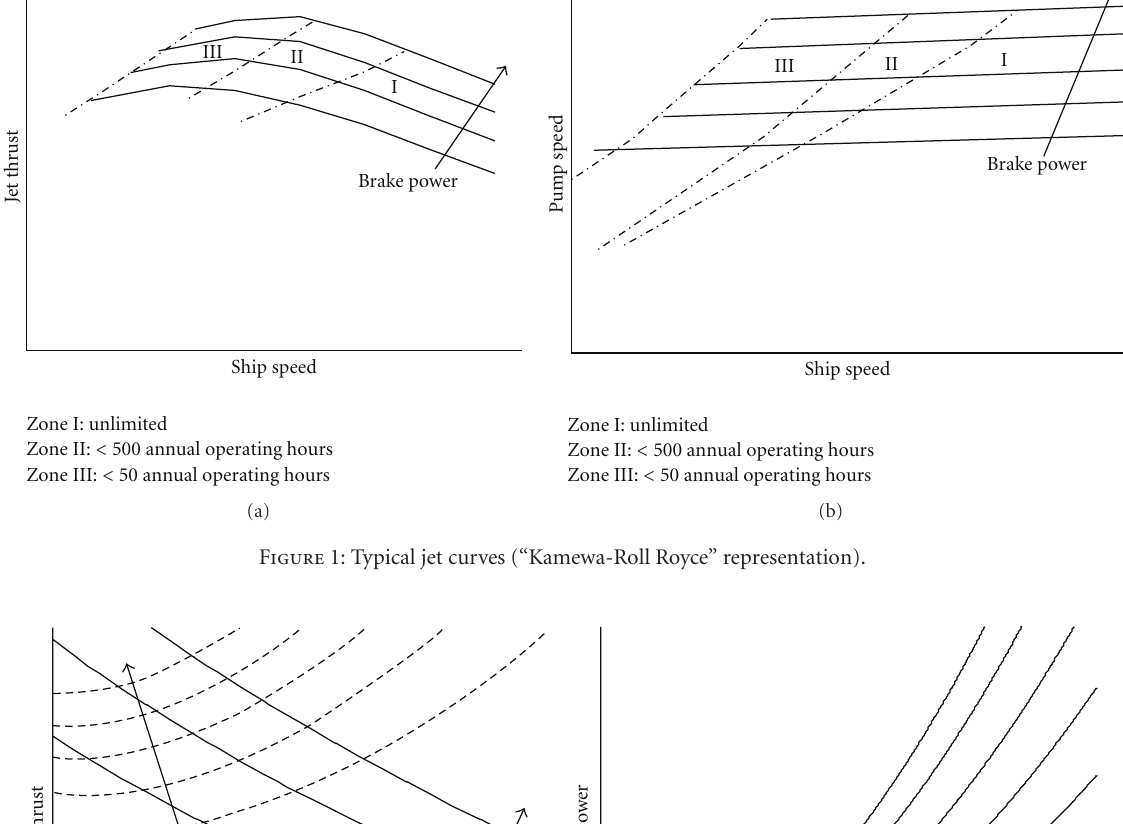
Figure 1: Typical jet curves (“Kamewa-Roll Royce” representation).